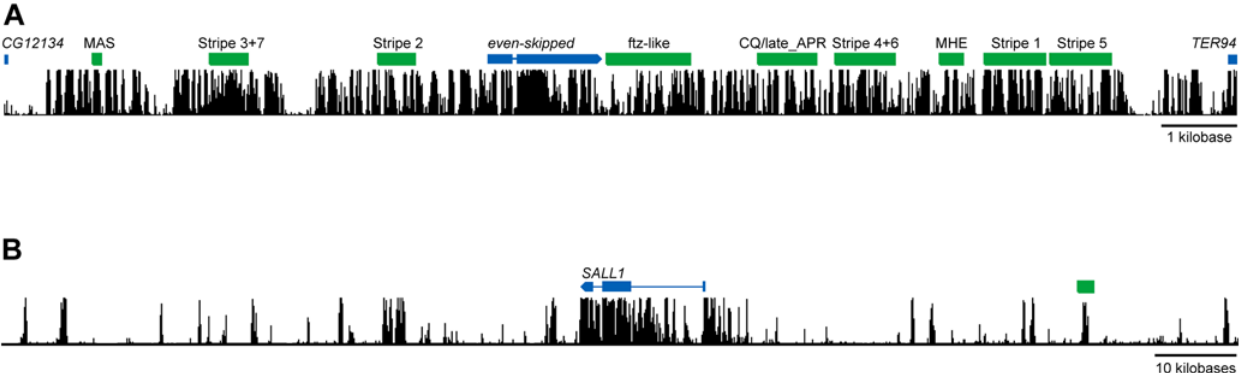
Figure 2. Landscape of sequence conservation in vertebrates and Drosophila . Posterior probabilities of selective constraint are plotted across illustrative loci in Drosophila and vertebrates (computed with PHASTCONS [44]; data obtained from UCSC genome browser). Blue annotations indicate coding regions, green indicate experimentally validated enhancers. A) Genomic interval surrounding the D. melanogaster even-skipped gene (conservation shown is for 12 Drosophila species plus Anopheles , Apis , and Tribolium ). Several confirmed eve enhancers are shown, drawn from the RedFly database [28,47]. B) Approximately 150 kb of the human SALL1 locus (conservation shown is across all vertebrates). The midbrain and neural tube enhancer depicted here is from [48].